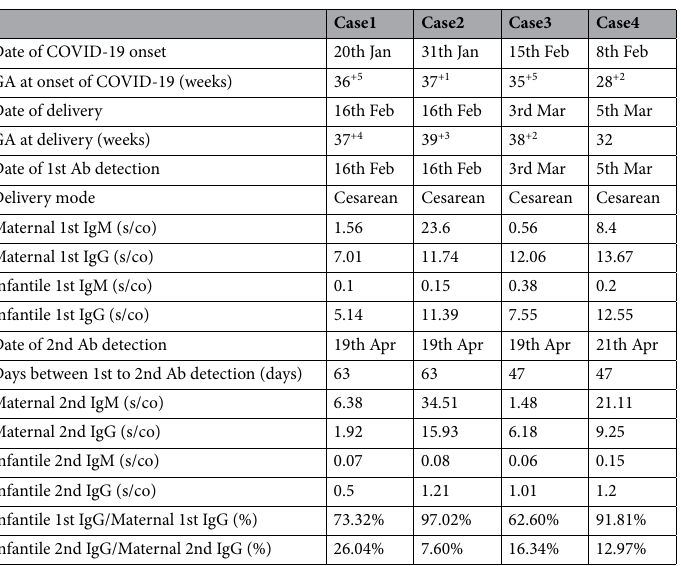
Table 3. Detailed follow-up data of 4 mothers and 4 infants. GA gestational age, Ab